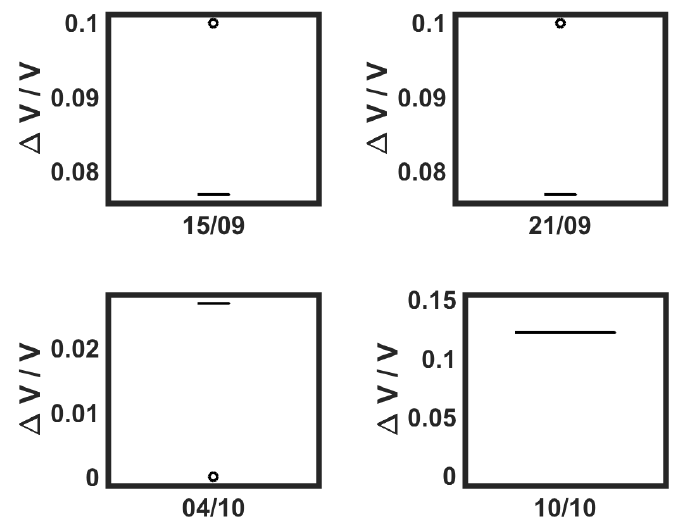
Figure 15. Sensor voltage output for aerial measurements on different days.